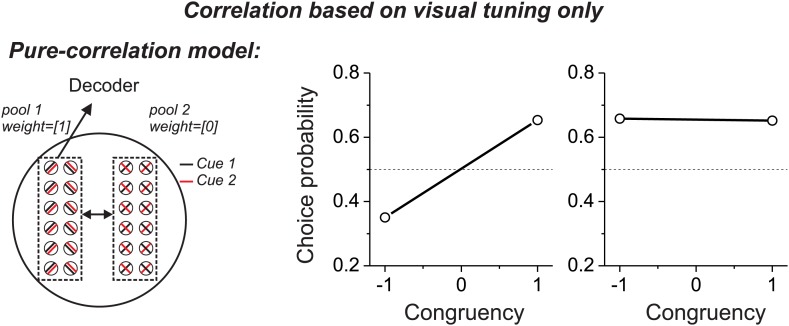
Predictions from a variant of the pure-correlation model in which correlated noise depends only on signal correlations from the visual tuning curves.This modification reverses the patterns of CPs across stimulus conditions, as compared to Figure 2C,D. This pattern of results is not consistent with experimental data.